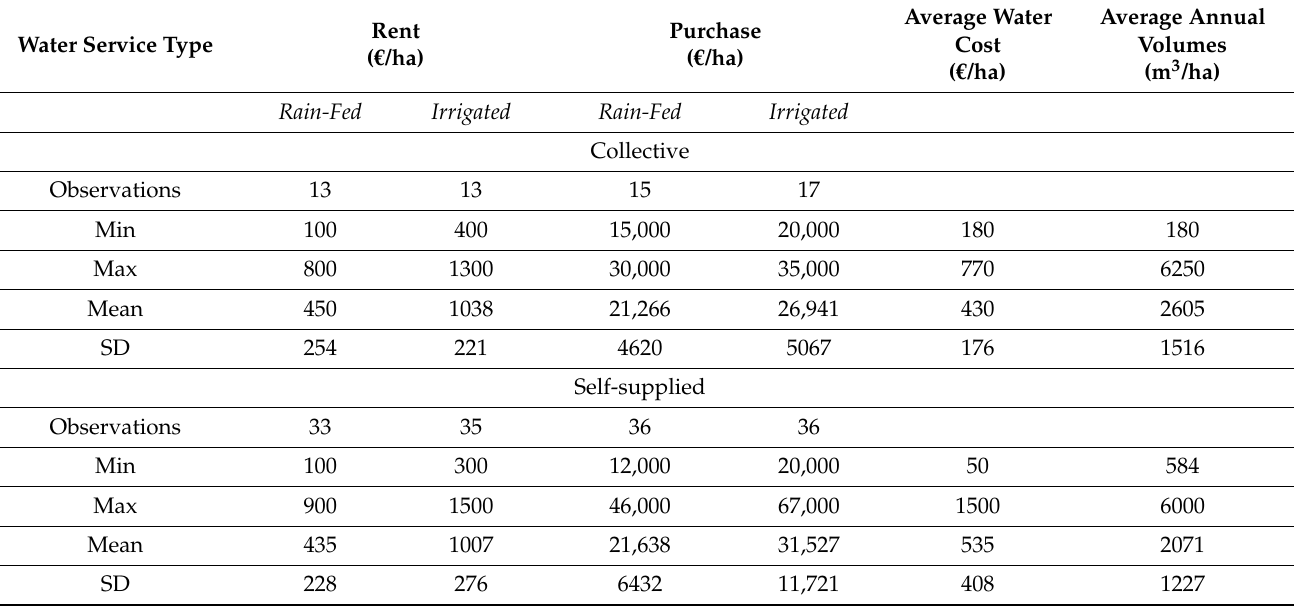
Table 8. Descriptive statistics of rental/purchase land prices and water